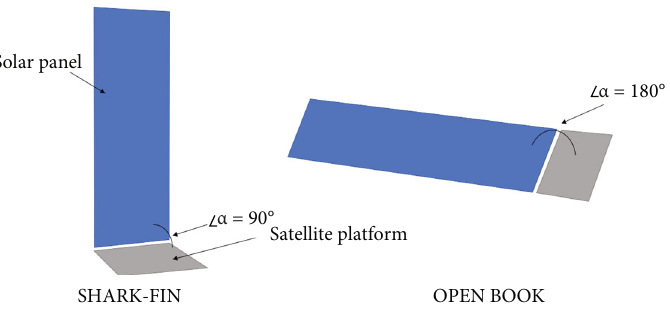
Figure 9: Starlink satellite attitude diagram.